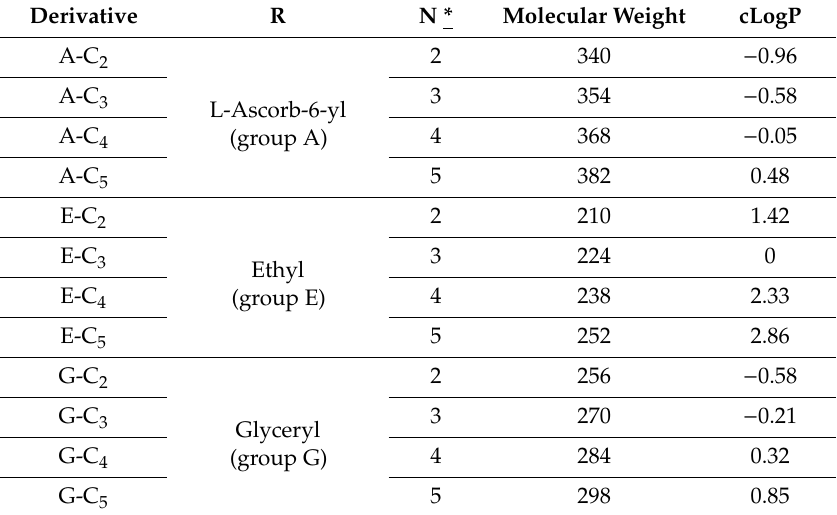
Table 1. Sample name, molecular weight and cLogP of the resorcinol